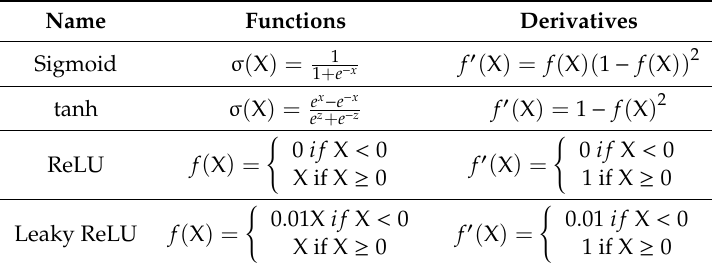
Table 2. Common activation functions.